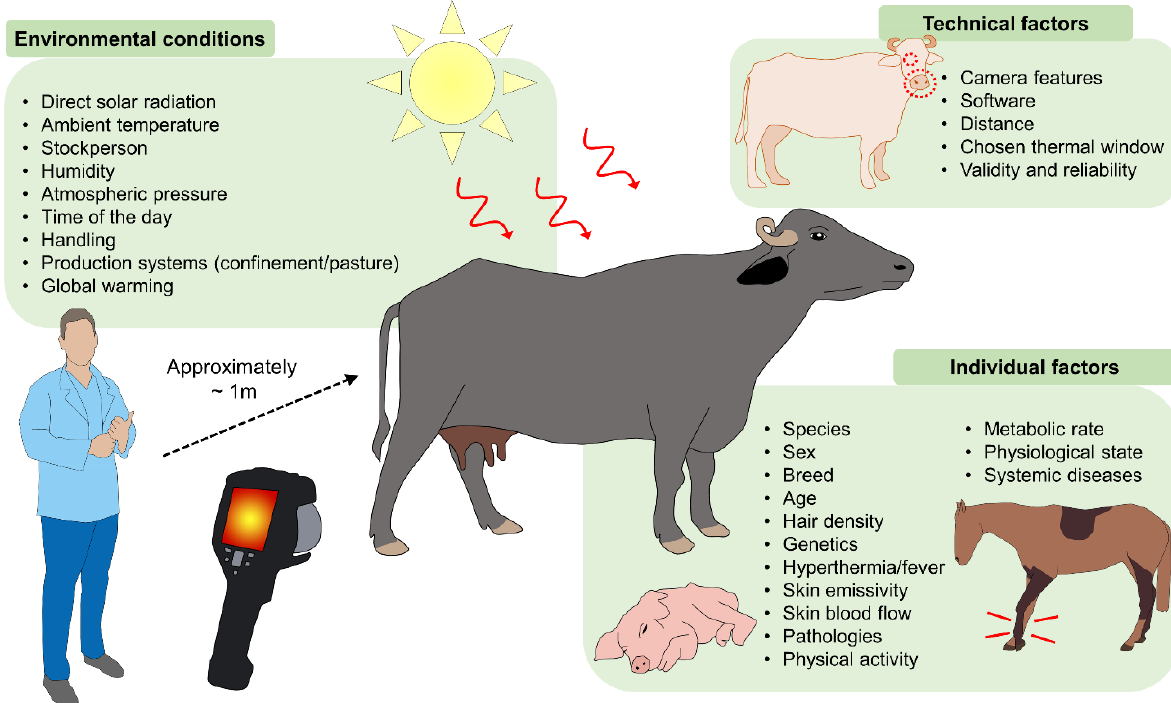
Figure 8. Environmental, technical, and individual factors that can influence the thermal responses of domestic animals. As a non-invasive tool that measures thermal fluctuations in the surface skin of animals, IRT can be affected by diverse agents, both extrinsic and intrinsic. Critical environmental conditions include direct solar radiation, ambient temperature, humidity, other climatic factors, and elements that depend on the stockperson, handling, and animal management. Individual factors that must be considered are species, breed, anatomical particularities, and acquired conditions, such as physical activity, systemic diseases, and physiological states. Potentially significant technical factors include the distance between observer and animal, the angle at which readings are taken, and the thermal window